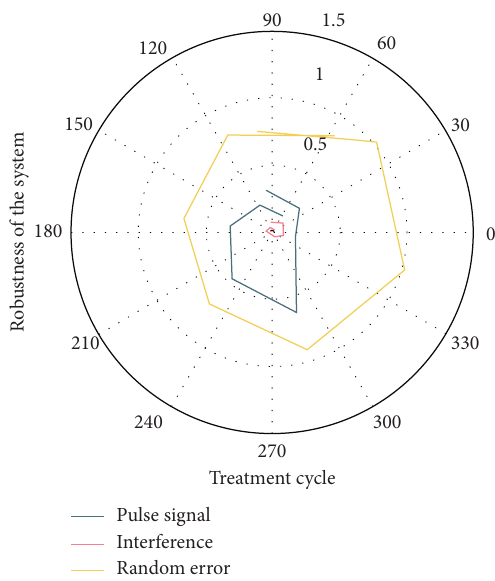
Figure 3: Improvement of the flexibility and stability of the measurement system.